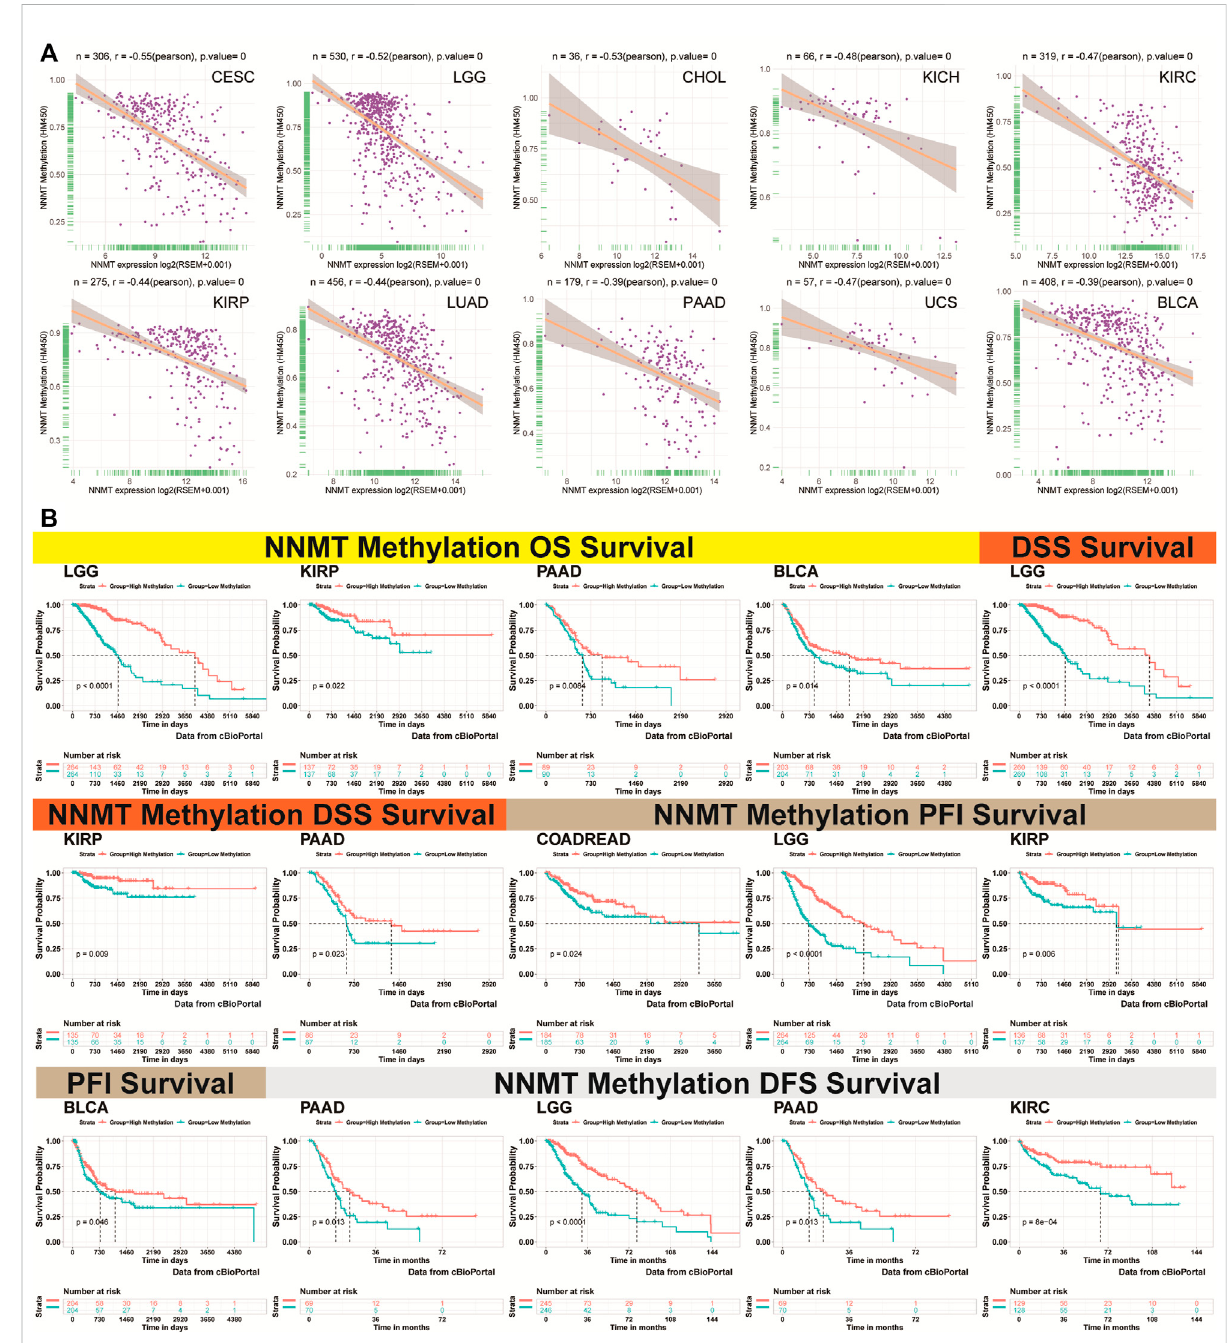
FIGURE 13 Association between NNMT expression and methylation of gene promoters. (A) Correlation between NNMT expression and gene promoter methylation in the 10 most prevalent malignancies, namely CESC, LGG, CHOL, KICH, KIRC, KIRP, LUAD, PAAD, UCS, and UVM. (B) Correlation betweenNNMTmethylationOSinLGG,KIRP,PAAD,andBLCA;DSSinLGG,KIRP,andPAAD;PFIincolonadenocarcinoma/rectumadenocarcinoma esophageal carcinoma (COADREAD), LGG, KIRP, and BLCA; and DFS in PAAD, LGG, KIRP, and